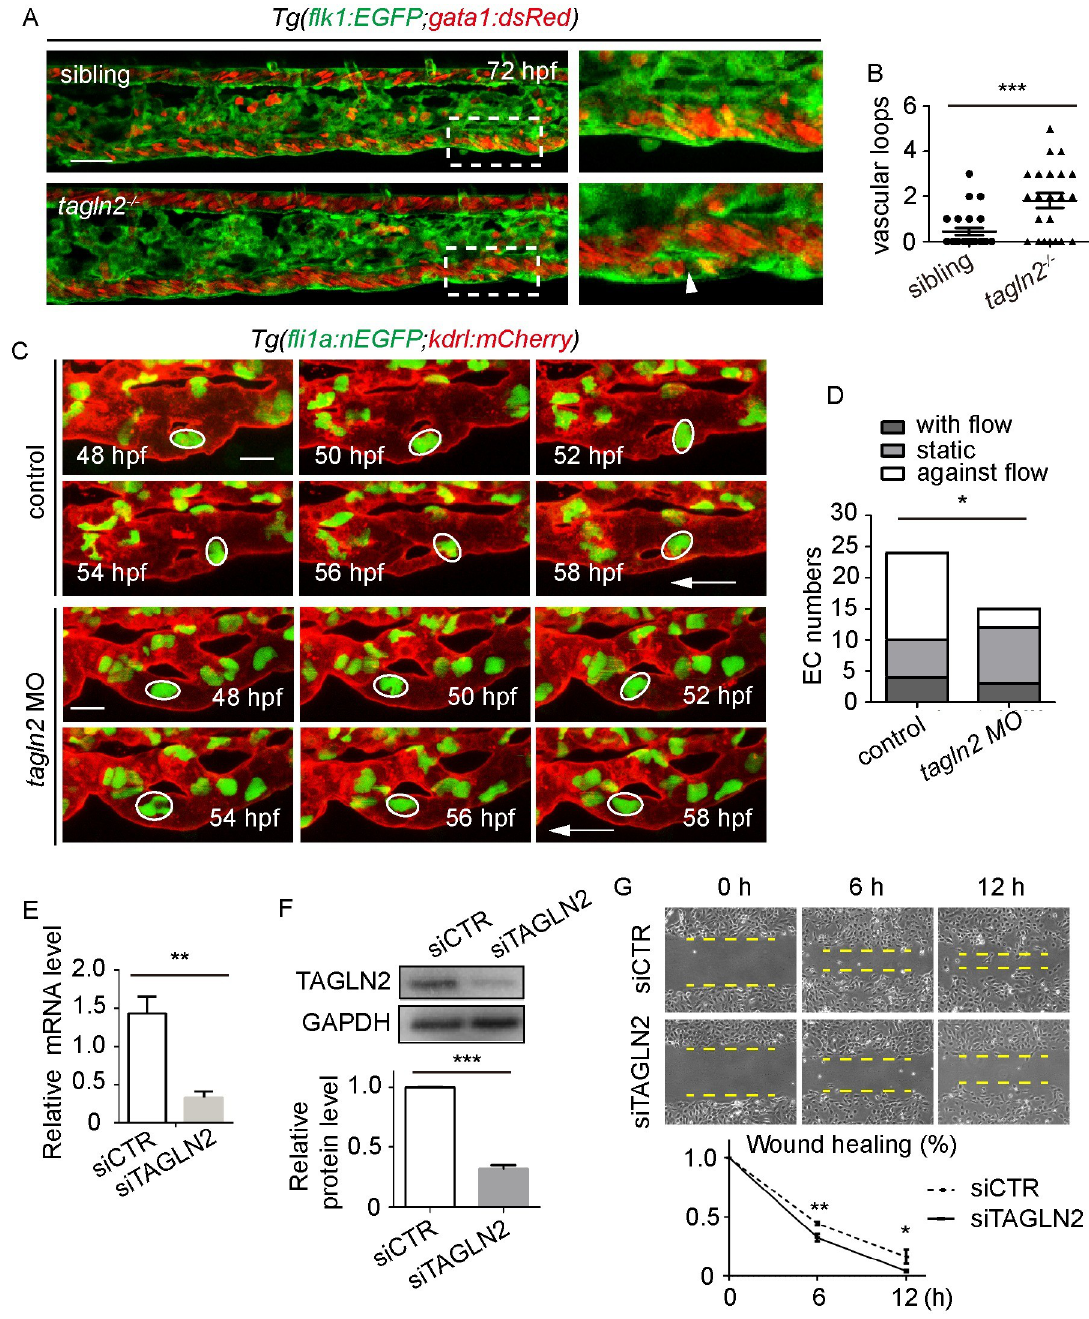
Fig 7. Tagln2 regulates CV pruning by promoting EC nucleus migration. (A) Role of tagln2 in CV pruning in zebrafish embryos. Boxes show enlarged images of the CV. The arrowhead indicates unpruned vessel. Scale bar: 50 μ m. (B) Quantification of vascular loops in sibling and tagln2 -/- embryos: sibling, n = 25 embryos; tagln2 -/- , n = 23 embryos. P = 0.0004. Student’s unpaired two-tailed t test. (C) Time-lapse live imaging of Tg(fli1a : EGFP;kdrl : mCherry) embryos shows EC nucleus migration in CV pruning in control or tagln2 morphant. Arrows indicate the direction of the blood flow. Colored circles indicate the EC nuclei. Scale bar: 10 μ m. (D) Direction of EC nucleus migration in the regressing vessel. The direction is classified into three types: with the flow, static, and against the flow. A total of 12 vascular loops with 24 EC nuclei and 8 vascular loops with 15 EC nuclei were calculated in the control group and tagln2 morphant, respectively. Unpaired two-tailed chi-square test. P = 0.0471. (E) and (F) Efficiency of siTAGLN2 in HUVECs at the mRNA ( P = 0.0094) and protein ( P < 0.0001) levels. (G) Wound healing of siCTR-transfected and siTAGLN2-transfected HUVECs. Statistics for wound healing after siCTR and siTAGLN2 transfection: 6 h, P = 0.0037; 12 h, P = 0.0252. (E)-(G) Student’s unpaired two-tailed t test. � P < 0.05, �� P < 0.01, ��� P <